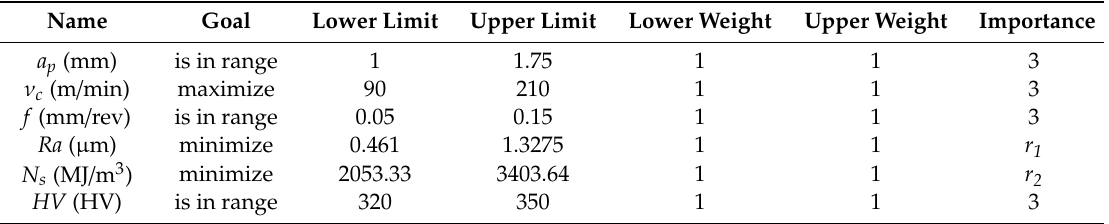
Table 9. Constraints on multi-objective